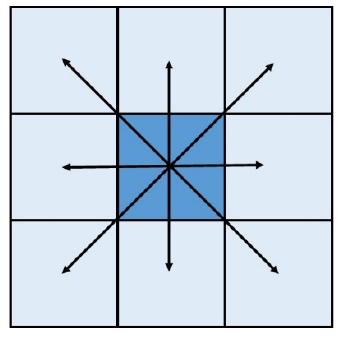
Figure 1. Cell flow direction.